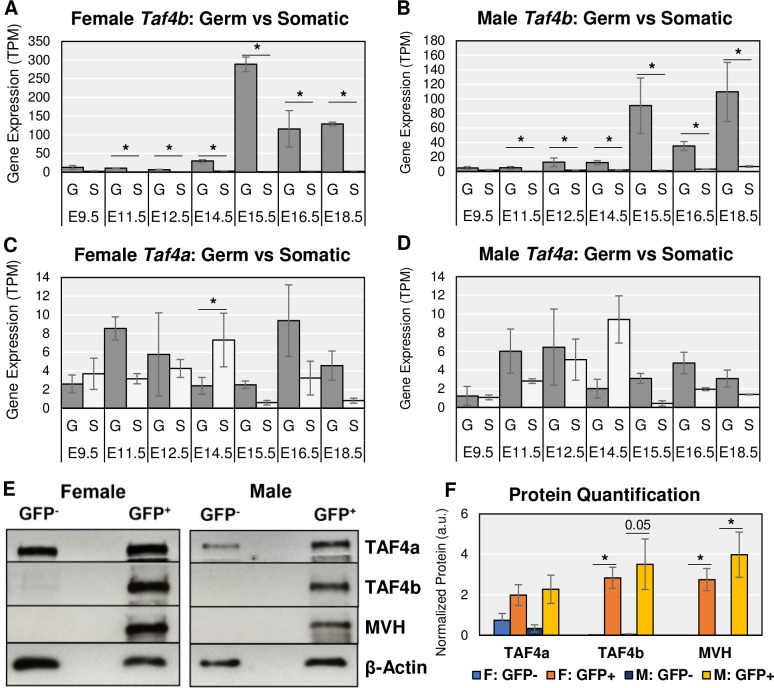
Taf4a vs Taf4b enrichment in the germ cells of the mouse embryonic gonad.Gene mRNA expression levels of Taf4b (A-B) and Taf4a (C-D) in female and male embryonic germ cells (“G”) and somatic cells (“S”) from E9.5 to E18.5 indicate that Taf4b is significantly (* = log2FC > |0.25|, p-adj. < 0.05) and consistently enriched in germ cells from E11.5 to E18.5 in comparison to somatic cells. Error bars indicate ± standard error of the mean (SEM). (E) Western blot protein signal of TAF4a and TAF4b in cells sorted from E13.5 Oct4-EGFP gonads. Mouse Vasa Homology (MVH) is a germ cell marker, which is only detected in the GFP+ lanes of the female and male samples, indicating that the GFP- lane contains only somatic cells. TAF4a protein signal is detected in all lanes (both germ and somatic cell types), whereas TAF4b is only detected in the GFP+ lane (germ cells). β-Actin is a protein loading control. Two female mice and two male mice were used to obtain roughly 35,000 pooled cells for each lane. (F) Western blot experiment performed in 3 replicates was quantified for relative protein signal. TAF4b protein levels between GFP+ and GFP- cells in female E13.5 ovary are significantly (* = p < 0.05, unpaired t-test) different. MVH is significantly different for both females and males. Error bars indicate ± SEM.